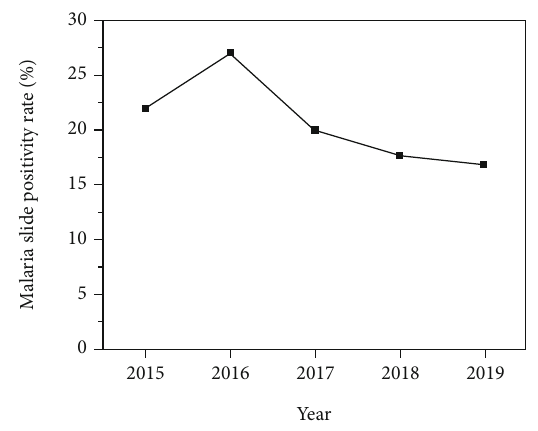
Figure 1: Trends of malaria prevalence at MHC, northwest Ethiopia, from Table 1: Annual trends of total malaria cases in MHC, from 2015- 2019. Blood fi lms examined Slide-con fi rmed malaria cases (%)